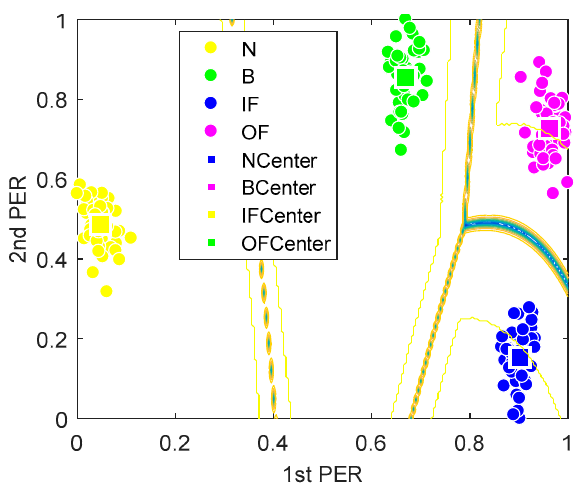
Figure 4. The spatial graph of Gath–Geva (GG) clustering for permutation entropy.